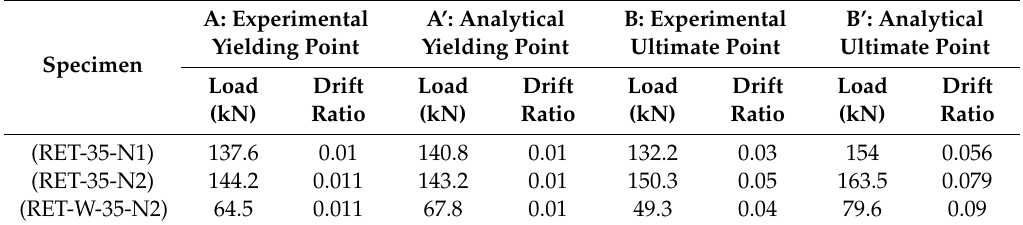
Table 8. Yielding and ultimate load-drift ratio data for the experimental and analytical results (Ilki et al. [22]).